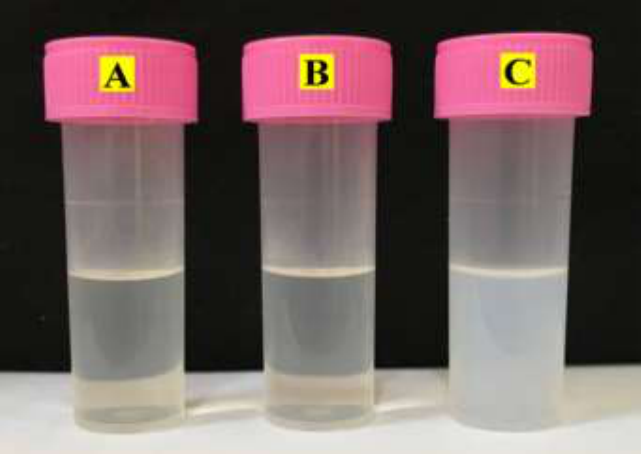
Figure 3: Stages of the chemical reaction for P407 loaded with RES, the color change is detected with reaction progrition. A: RES, B: P407, C: RES-loaded